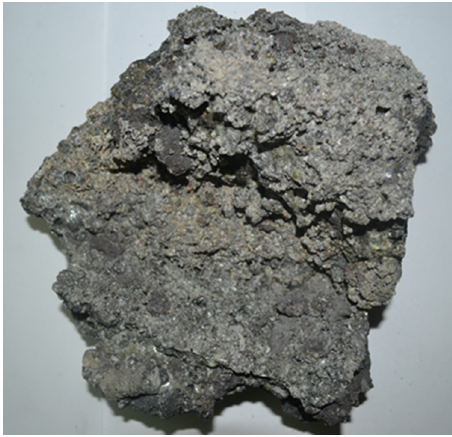
Figure 1. A large chunk of palm oil clinker (POC).